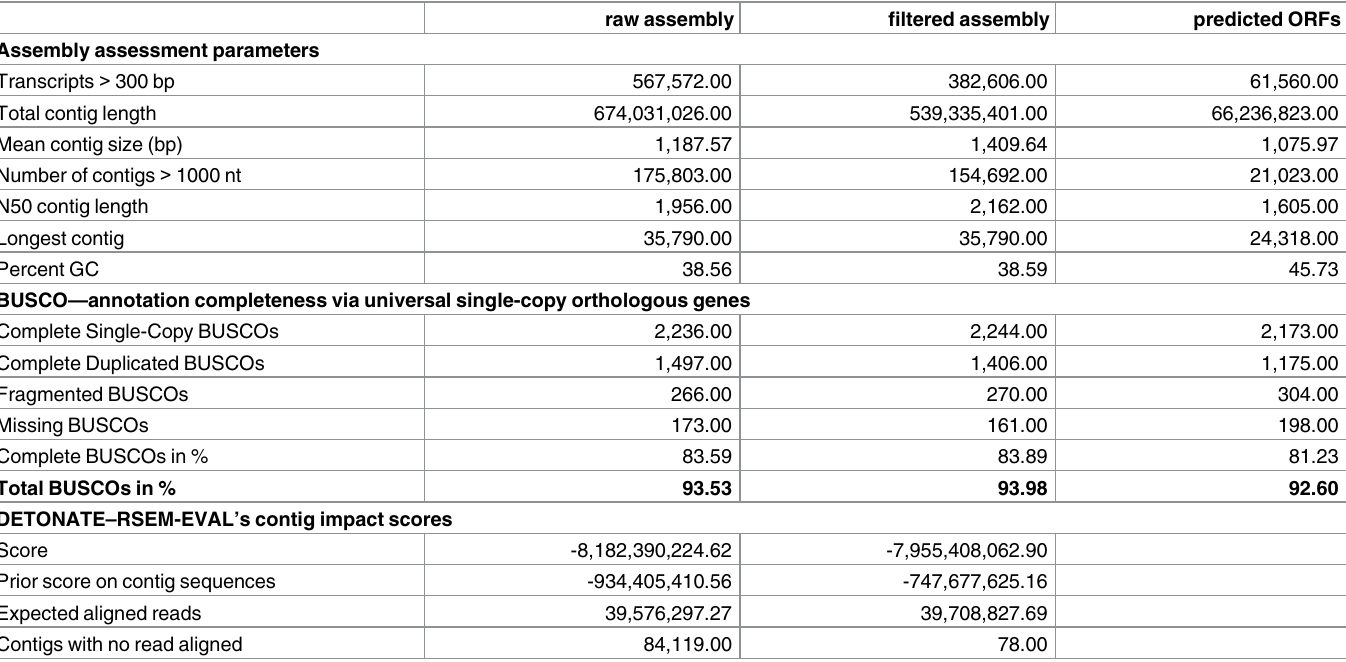
Table 2. Assemblystatistics during final assembly evaluation